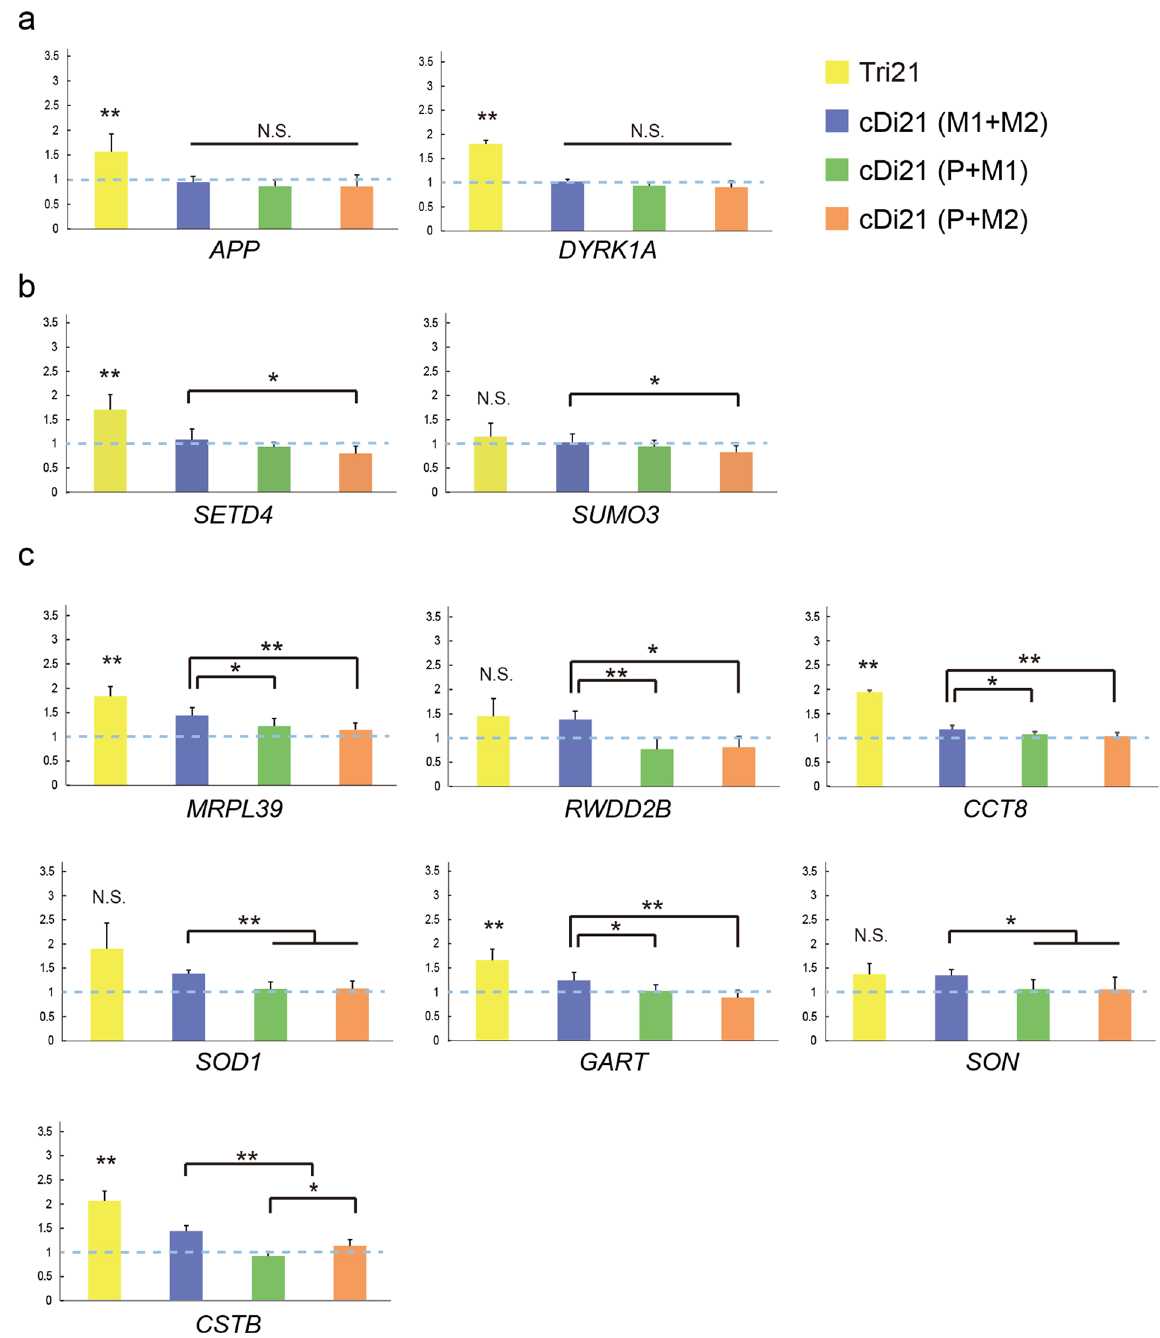
Figure 5. Gene expression analysis in Tri21 and cDi21 iPSCs. Relative expression levels of genes on chromosome 21 in Tri21 (yellow, n = 3), cDi21(M1 + M2) (blue, n = 9), cDi21(P + M1) (green, n = 9) and cDi21(P + M2) (orange, n = 9) iPSCs. Gene expression was normalised to that of Di21. ( a ) Genes whose expression levels did not differ markedly between cDi21 iPSCs (see also Supplementary Fig. S5). ( b ) Genes whose expression levels were higher in cDi21(M1 + M2) than in cDi21(P + M2) (see also Supplementary Fig. S6). ( c ) Genes whose expression levels were higher in cDi21(M1 + M2) than in cDi21(P + M1) and cDi21(P + M2). Error bars represent SEM. p values were determined by Student’s t-test or the Mann–Whitney U test. * p < 0.05, ** p <